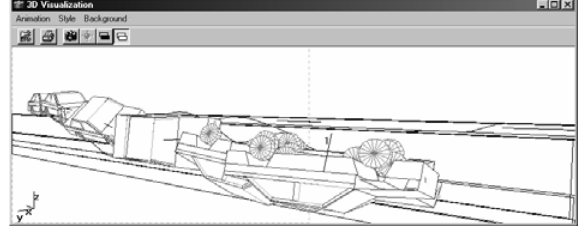
Fig 7. The view of overturning of the automobile in the space – from the front